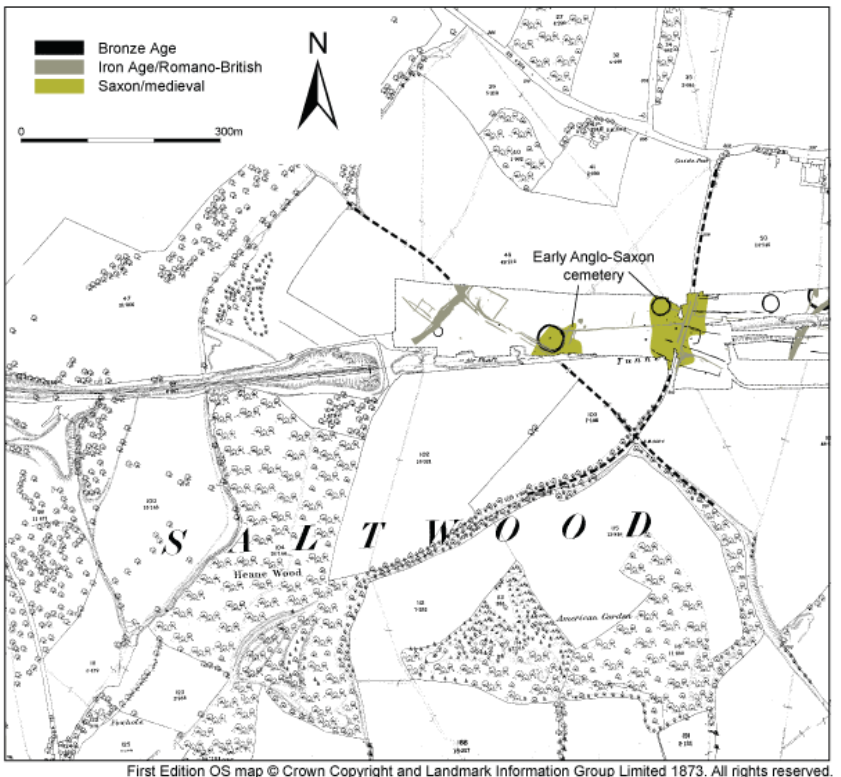
Fig. 3: Saltwood: a model of landscape continuity. Excavations have demonstrated the exist- ence of a fossilised landscape: trackways in use in the 19th century have been revealed to date to the Iron Age, whereas three groups of Anglo-Saxon burials cluster on Bronze Age and early medieval barrows which, in turn, became the site of a medieval open-air assembly-place, remembered as ‘Heane